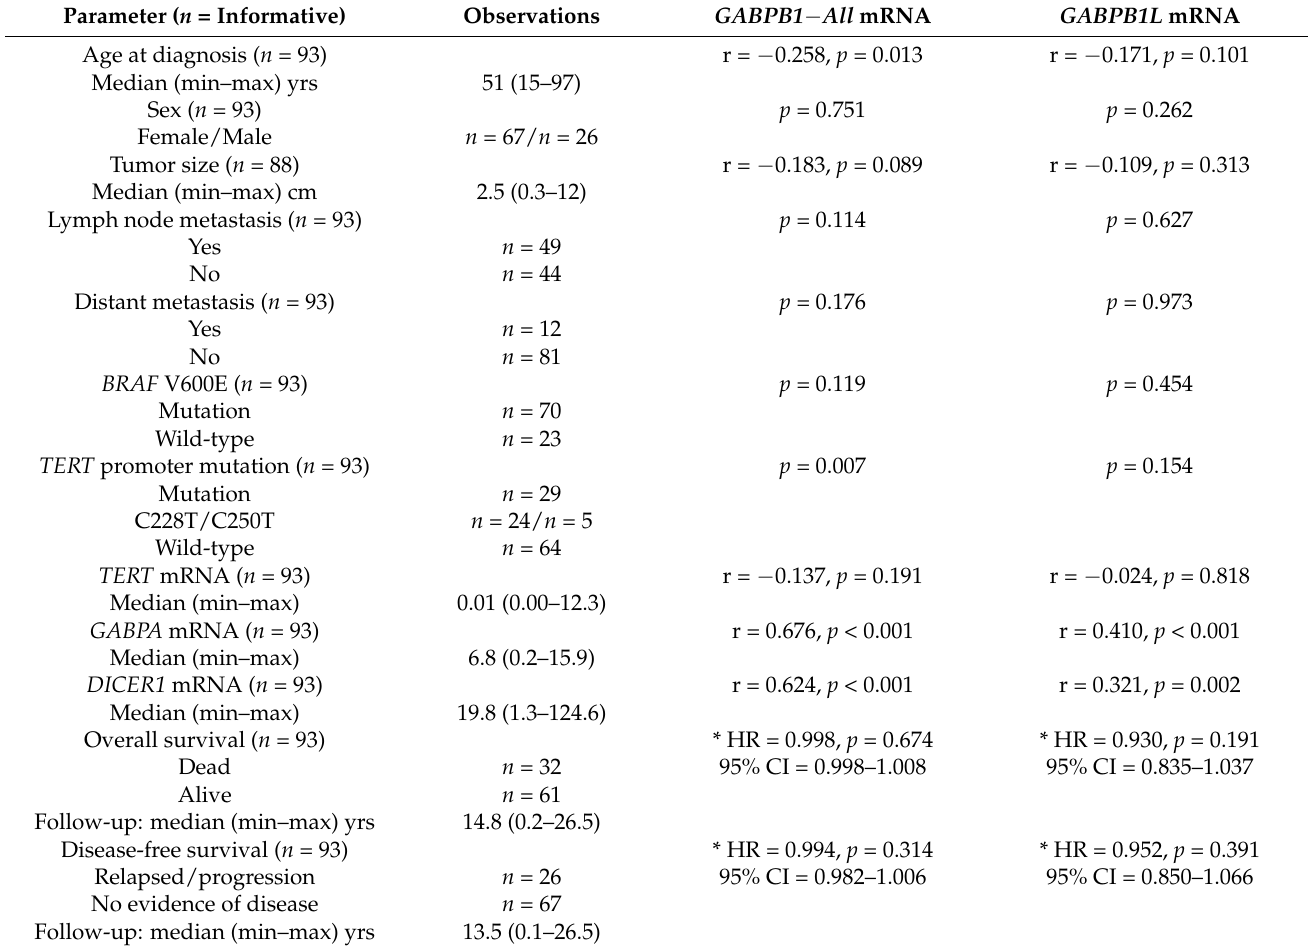
Table 1. Clinical characteristics and statistical comparison for the 93 PTC K cases in the